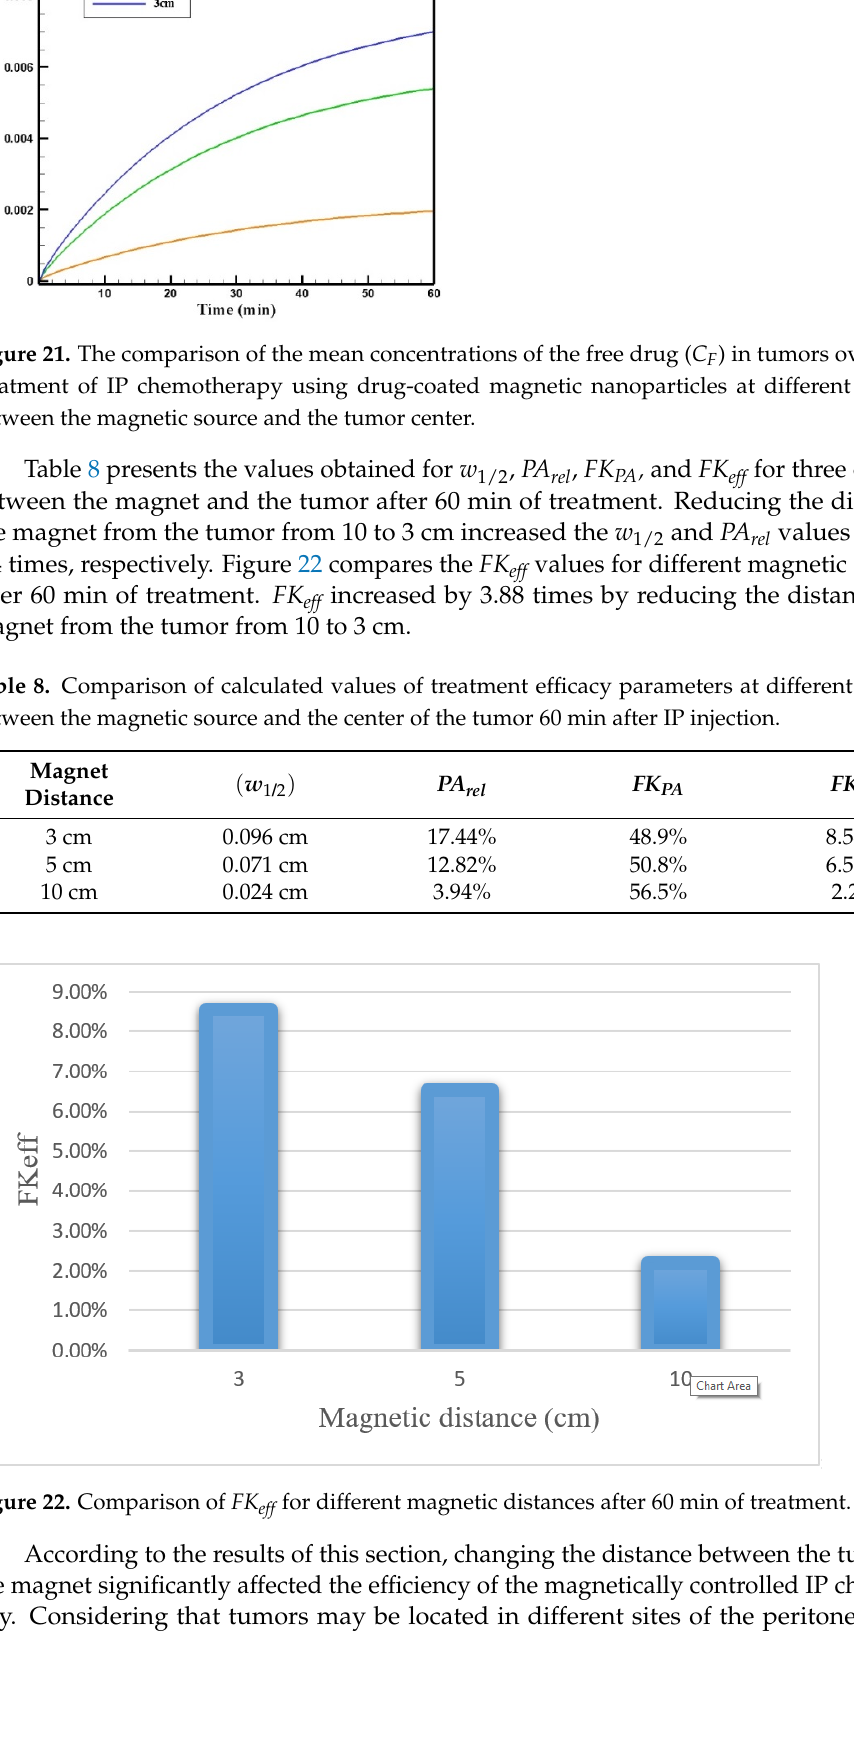
Figure 20. Free drug concentration (CF) contours 60 min after IP injection using drug-coated MNPs